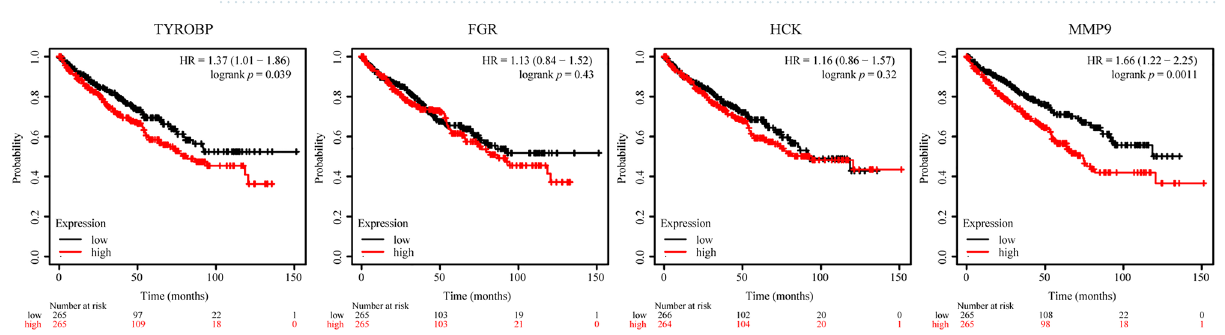
Figure 4. Expression of key genes in ccRCC. * p < 0.05; ** p < 0.01; *** p < 0.001.